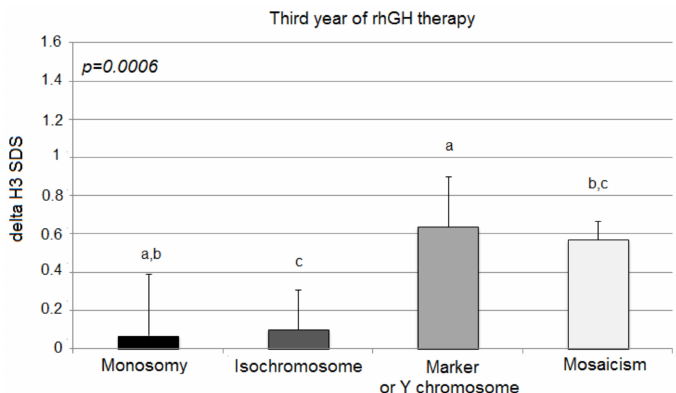
Figure 3. Growth response to rhGH during the third year of therapy. H3 SDS, height standard deviation score after 3 years of therapy; the ANOVA test was applied ( p < 0.001). Values (bars) marked with the same letters are significantly different (Dunn’s multiple comparisons test): a— p < 0.018; b— p < 0.011; c— p < 0.043. The groups designed with the same letter different